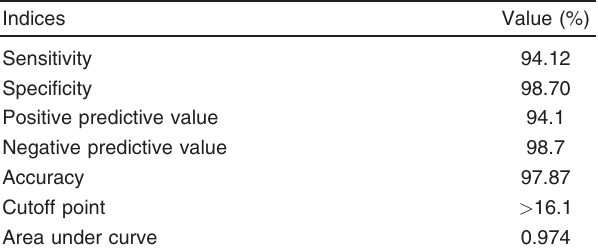
Table 3 Diagnostic performance of red cell distribution width in prediction of mortality in patients with community-acquired pneumonia Indices Value